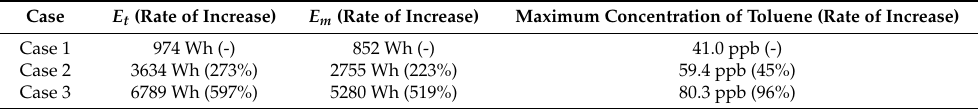
Figure 8. Results of CFD (computational fluid dynamics) analysis (Case 3, time = 600 s, Section XY, Z = 0.9 m). Table 8. Energy consumption and maximum concentration of toluene per case.